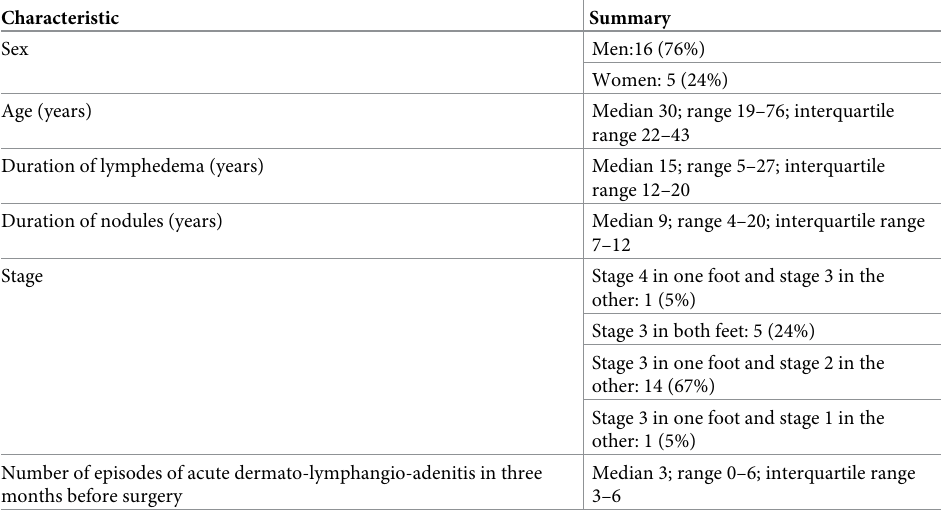
Table 1. Demographic and clinical characteristics of podoconiosis patient (n = 21) who have undergone surgical nodulectomy in Bahir Dar, Ethiopia between January 2015 and December 2019.